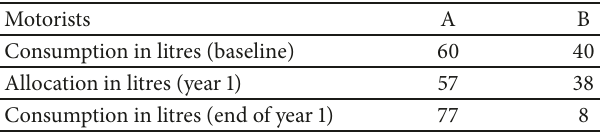
Table 2: Example: Initial distribution of free